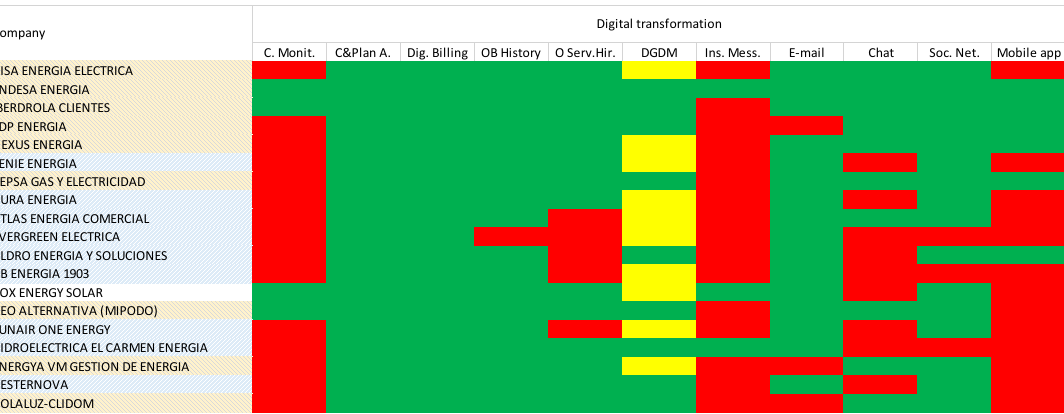
Figure A2. Summary of indicators of channel integration (II). Indicator coloring scheme: green = 1; red = 0. Company color scheme: yellow: Cluster 1; blue: Cluster 2; white: mixed results.